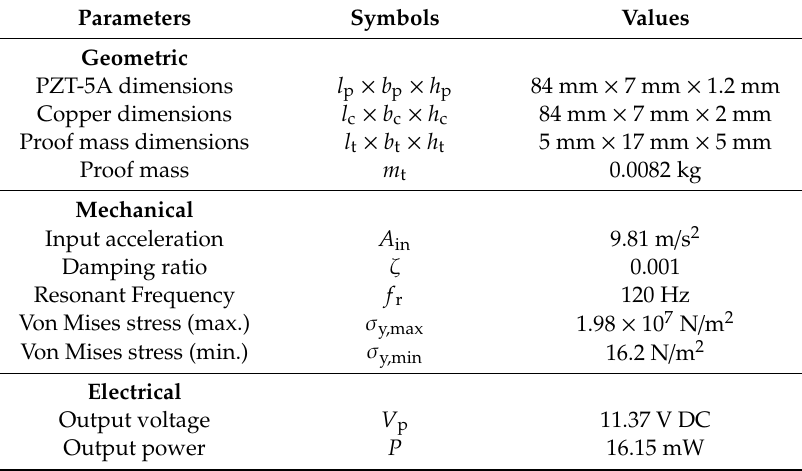
Table 4. Parameters of the optimised CB.